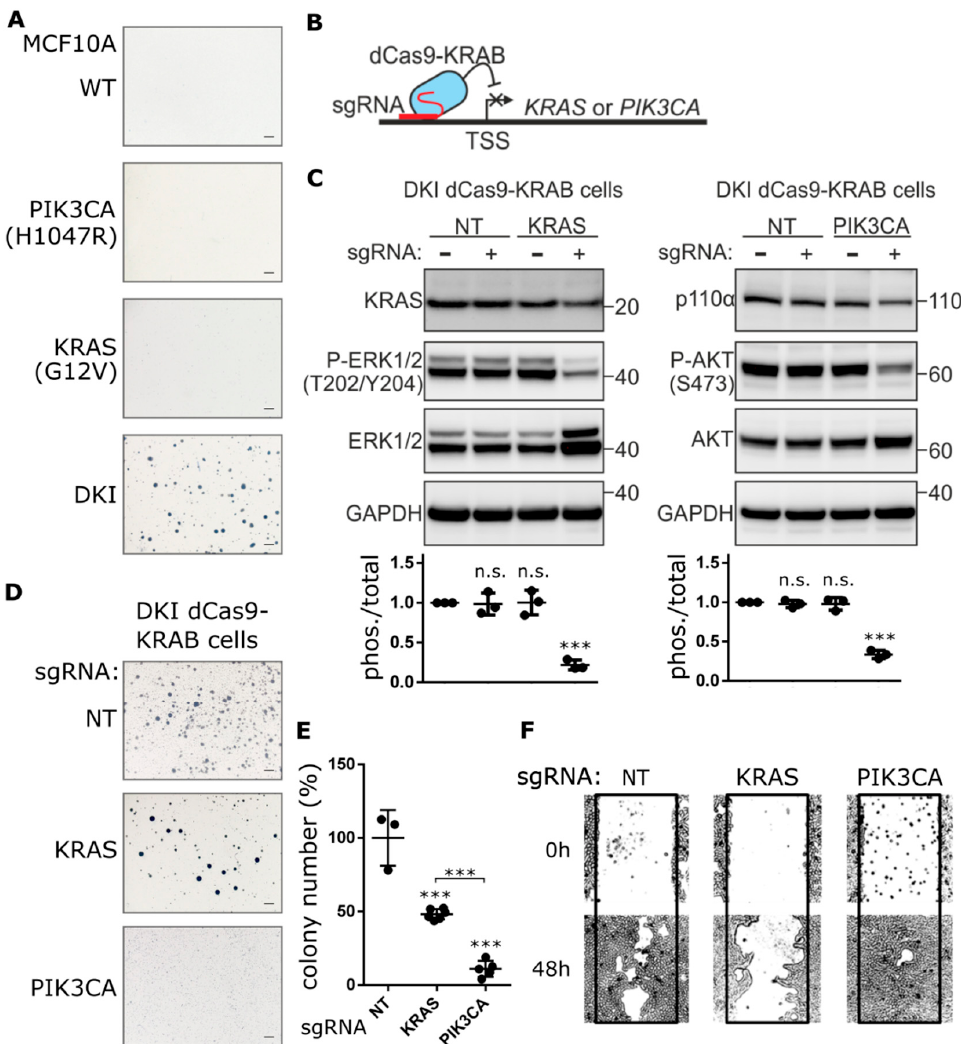
Figure 1. Knockdown of PIK3CA expression blocks anchorage-independent growth, not migration. ( A ) Representative images showing colony formation by MCF-10A cells grown in 0.3% agarose for 15 days. ( B ) Cartoon depicting CRISPRi-mediated gene repression. Single guide RNA (sgRNA) targets nuclease-dead Cas9 (dCas9), fused to the transcriptional repressor KRAB, to the transcription start site (TSS) of the gene of interest, thereby blocking transcription initiation. ( C ) KRAS and p110 α protein levels determined by immunoblot after CRISPRi-mediated repression of KRAS or PIK3CA genes in DKI cells. Downregulation of KRAS and PI3K signaling was assessed using phospho-specific antibodies targeting ERK (Thr202/Tyr204) and AKT (Ser473). Densitometric quantification of phospho vs. total blots (lower panels, Mean ± SD). ( D ) Soft agar colony formation after 21 days by DKI cells stably transduced with KRAS or PIK3CA targeting CRISPRi constructs. ( E ) Quantification of soft agar colonies (Mean ± SD). ( F ) Migration of DKI-dCas9-KRAB cells across a scratched wound over 48h. ***, p < 0.001 (unpaired t -test); n.s., not significant; NT, non-targeting sgRNA; scale bars = 100 μ m.